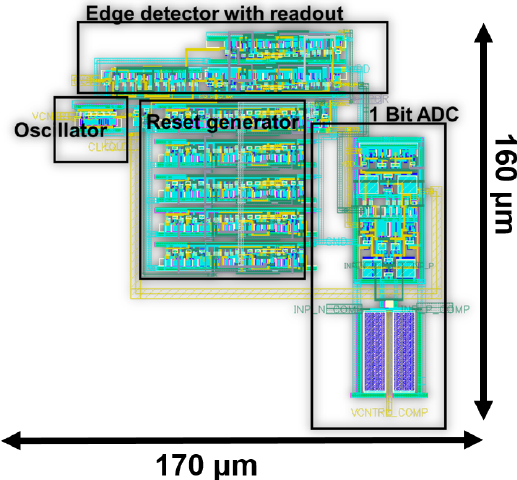
Figure 8. IC layout of the BPSK